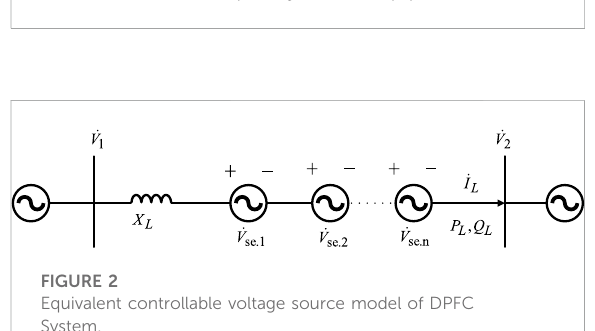
FIGURE 1 Basic structure of DPFC primary sub-unit equipment.